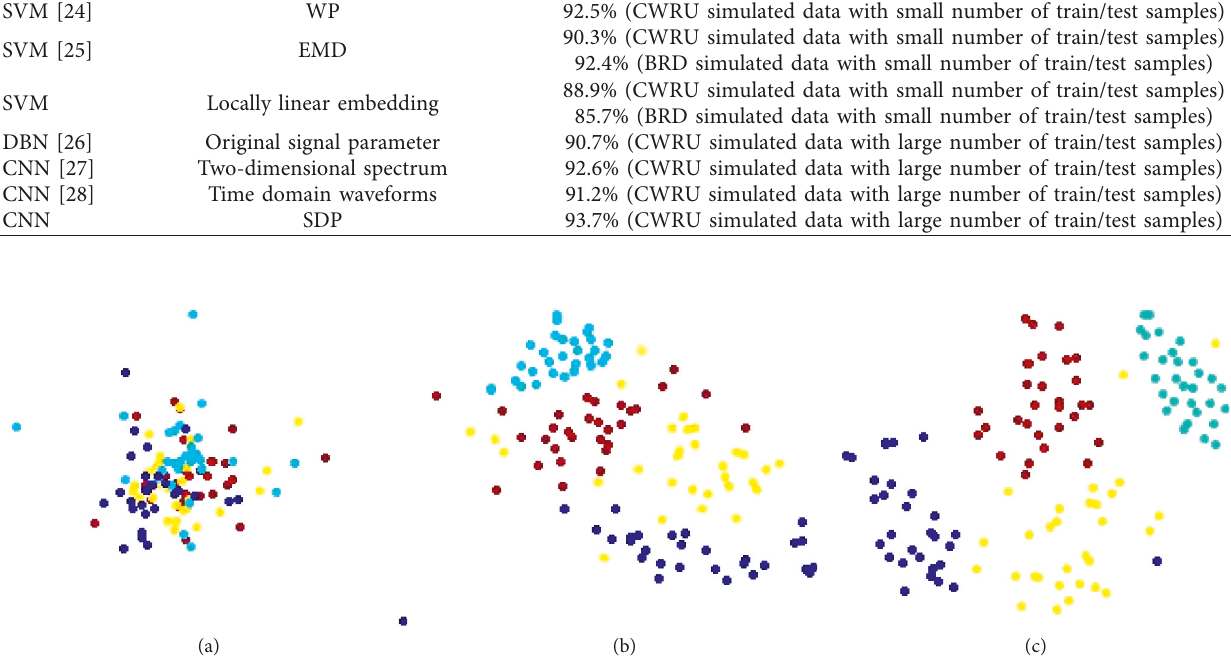
Figure 13: CNN model classification renderings. (a) The time-domain waveform image. (b) The time-frequency image. (c) The SDP